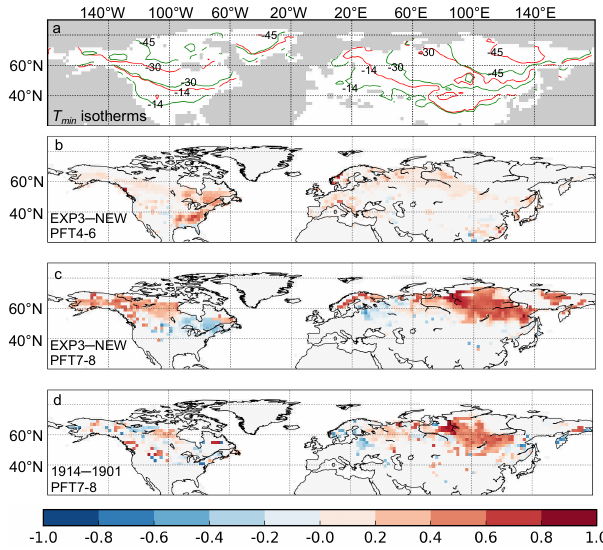
Figure 14. (a) minimum temperature ( T min ) isotherms calculated from the 20-year average climatology (red lines) and the mean of the 20 T min for each year (green lines). The T min values are la- beled on the lines, corresponding to the PFT-dependent T min,crit for temperate and boreal trees (see Table 1). (b, c) difference of the vegetation fractional cover for the last year of spin-up between EXP3 (using 20-year climatology as forcing file in spin-up) and NEW for temperate trees (PFTs 4–6) (b) and boreal broadleaf de- ciduous/needleleaf evergreen trees (PFTs 7–8) (c) . (d)